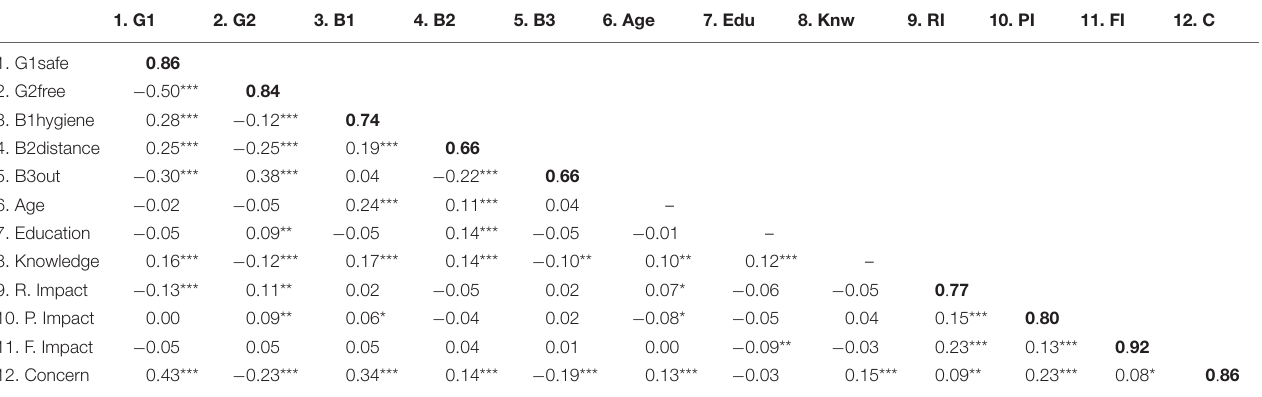
TABLE 4 | Pearson correlations among latent scores, Conway scales, COVID knowledge, age, and